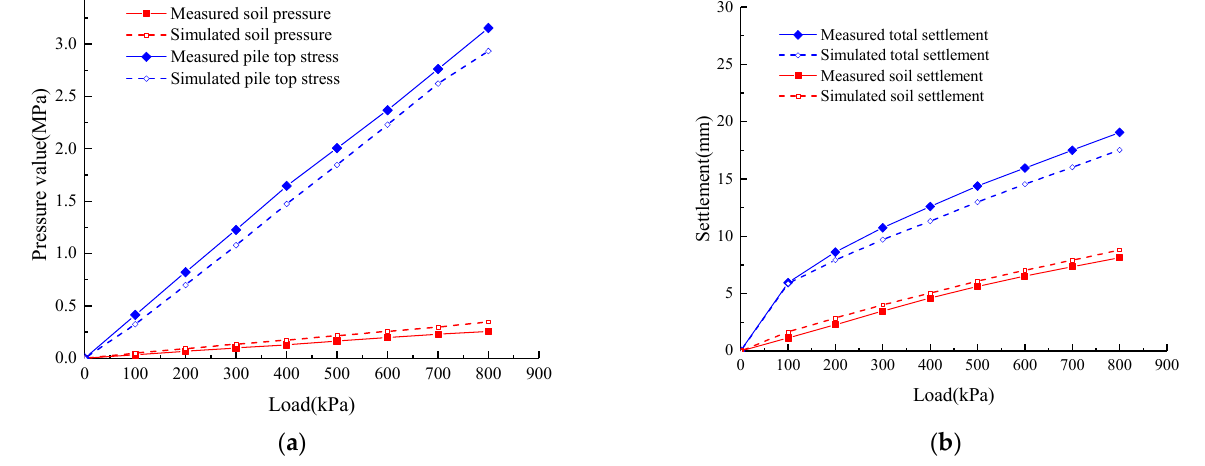
Figure 10. Comparison between measured value and simulated value in test-1: ( a ) stress; ( b ) settlement. Figure 11 is the settlement contour and stress contour in test-1 when loaded to 800